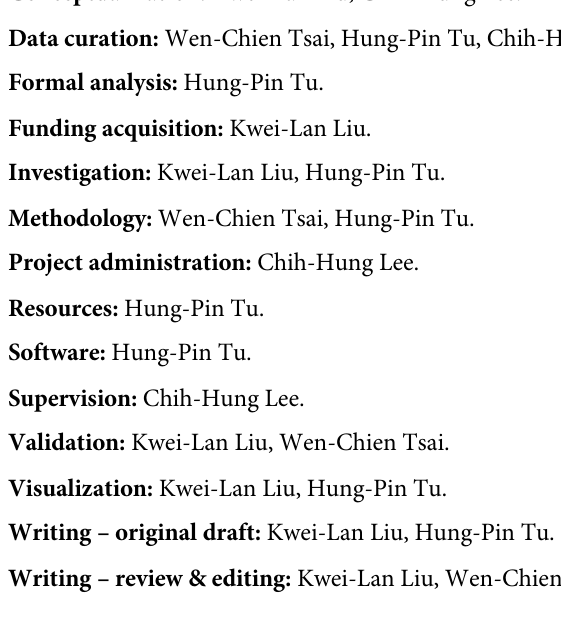
S1 Table. Details of statin treatment for hyperlipidemia in the psoriasis cohort and the hyperlipidemia